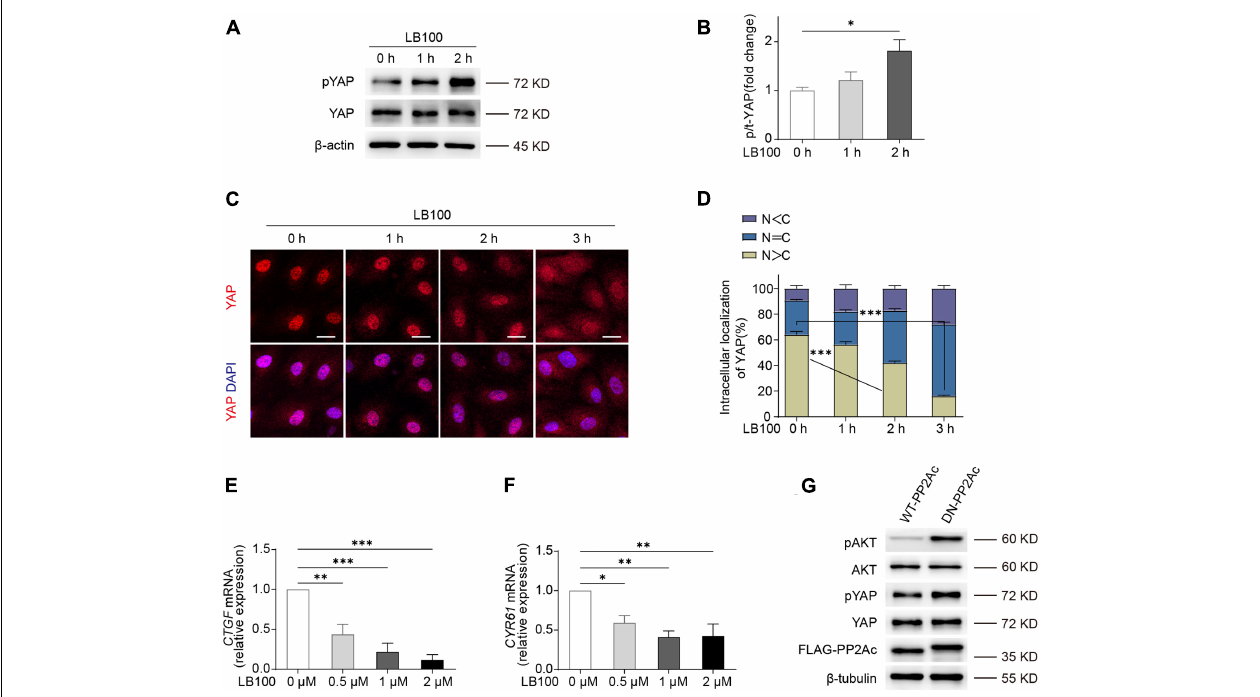
FIGURE 1 | PP2A regulate YAP activity in ECs. (A) Western blot detection YAP phosphorylation status treated with 2 µ M LB100 for the indicated time points. (B) Quantification of western blot shown in (A) . n = 4 independent experiments. (C) Representative images of HUVECs stimulated with 2 µ M LB100 for the indicated time points and stained for YAP and DAPI. (D) Quantification of YAP subcellular localization treated as in (C) . Data from approximately 200 cells from 12 random fields of view (at least three independent experiments). N, nucleus; C, cytosol. N < C, nuclear staining was weaker than cytoplasm; N = C, nuclear staining was equal to cytoplasm; N > C, nuclear staining is stronger than cytoplasm. (E,F) qPCR analysis the expression of YAP target genes CTGF, CYR61 in HUVEC treated with indicated dose of LB100 for 24 h. (G) Representative western blot showing pYAP status in HUVECs infected with WT-PP2Ac and DN-PP2Ac adenovirus for 36 h, pAkt was used as a positive control. Data are shown as mean ± SEM, one-way ANOVA followed by Tukey’s multiple comparisons test. ∗ p < 0.05, ∗∗ p < 0.01, ∗∗∗ p < 0.001, ns indicates not significant. Scale bars, 20 µ